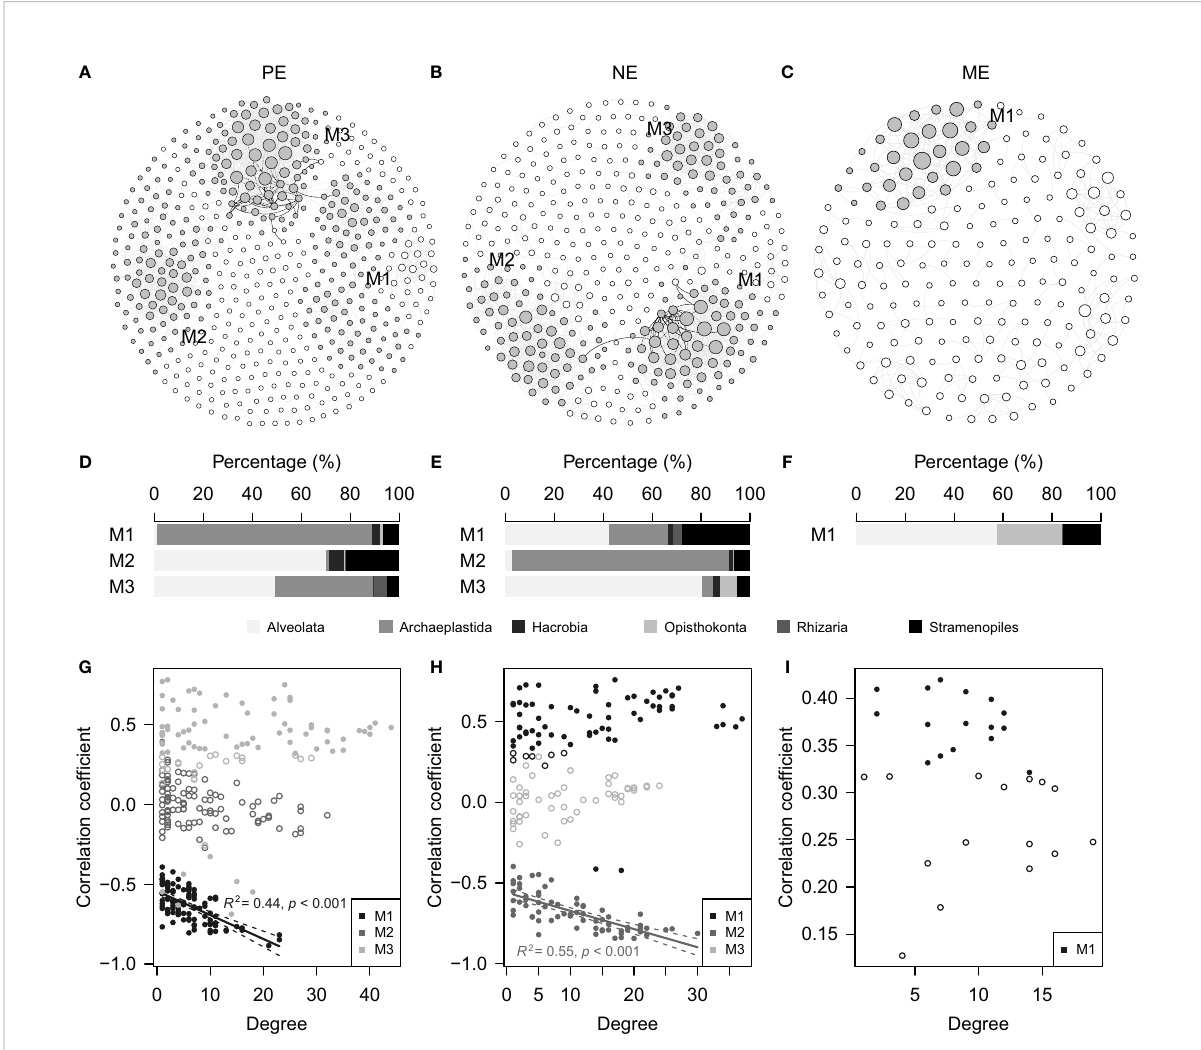
FIGURE 7 Co-occurrence networks showing the (A) PE, (B) NE and (C) ME categories. Major modules with >10% contributions to the total node degrees are marked with fi lled circles (3 modules in each of the PE and NE, and 1 module in the ME). Some of the nodes in (A) were manually moved to show a clear boundary among the M1 and M3 modules. (D – F) Horizontal stacked barcharts displaying the taxonomic compositions of the major modules shown in (A – C) , respectively. (G – I) Scatter plots illustrating the relationships between degrees and correlation coef fi cients inferred from Spearman ’ s rank correlations between the ASV relative abundance and PC 1. Signi fi cant and non-signi fi cant Spearman ’ s rank correlations are indicated by fi lled and open circles, respectively. Signi fi cant linear regressions ( p < 0.05), which include (G) M1 in PE and (H) M2 in NE are indicated by solid lines with a 95% con fi dence